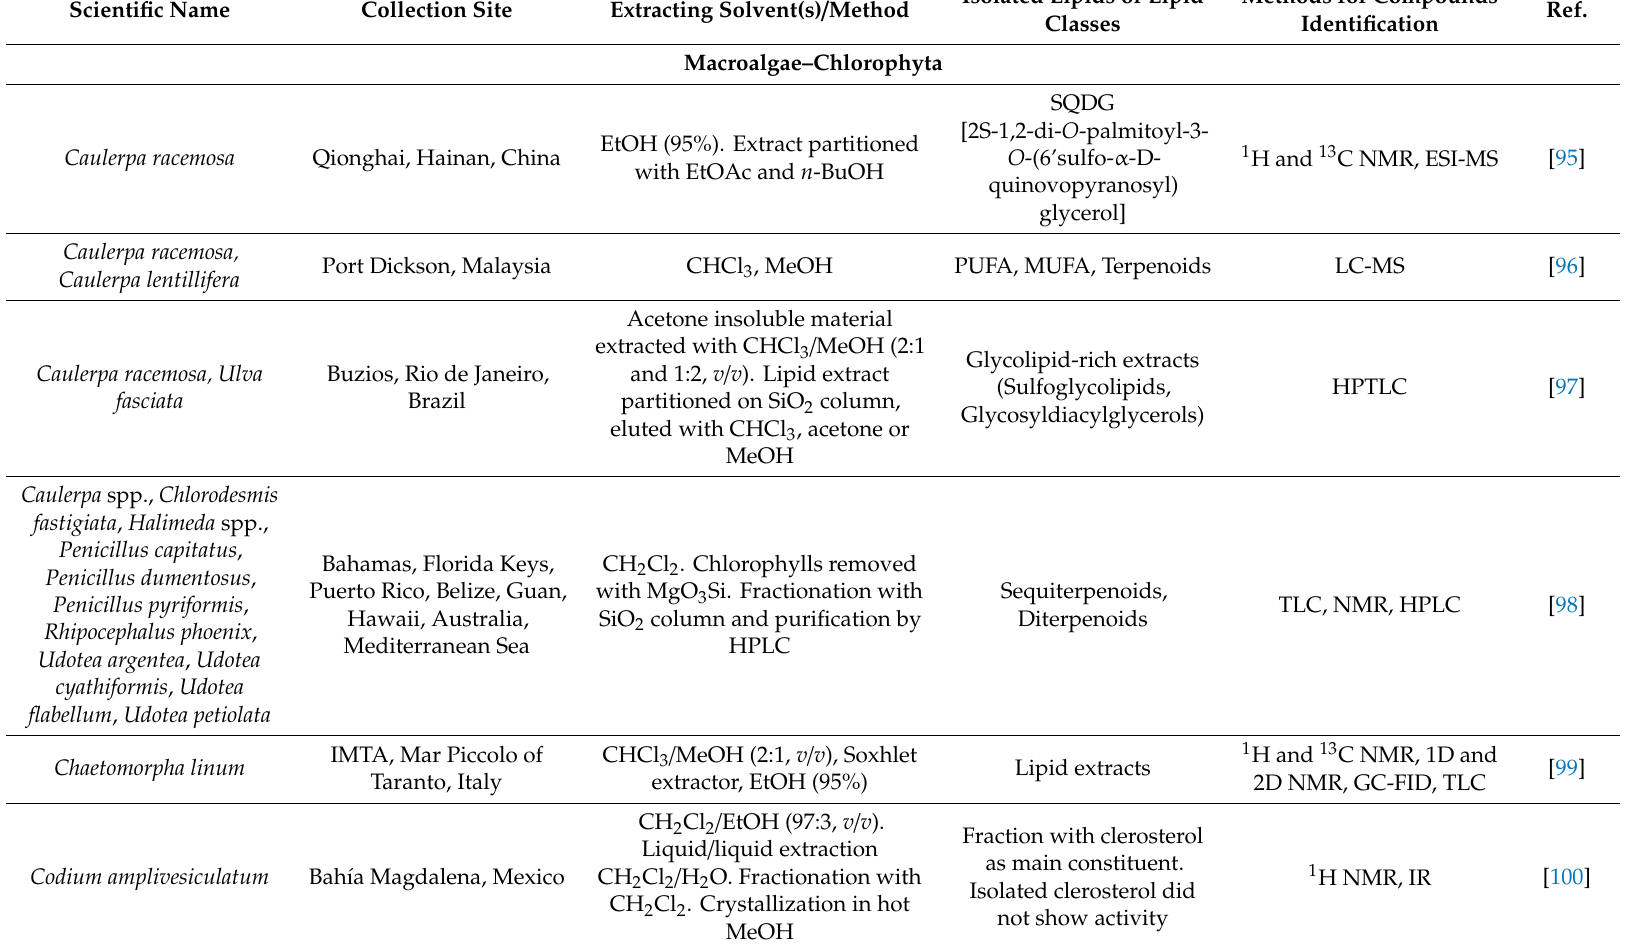
Table 3. Algae lipids and lipid-rich extracts with antimicrobial potential, their origin and extraction